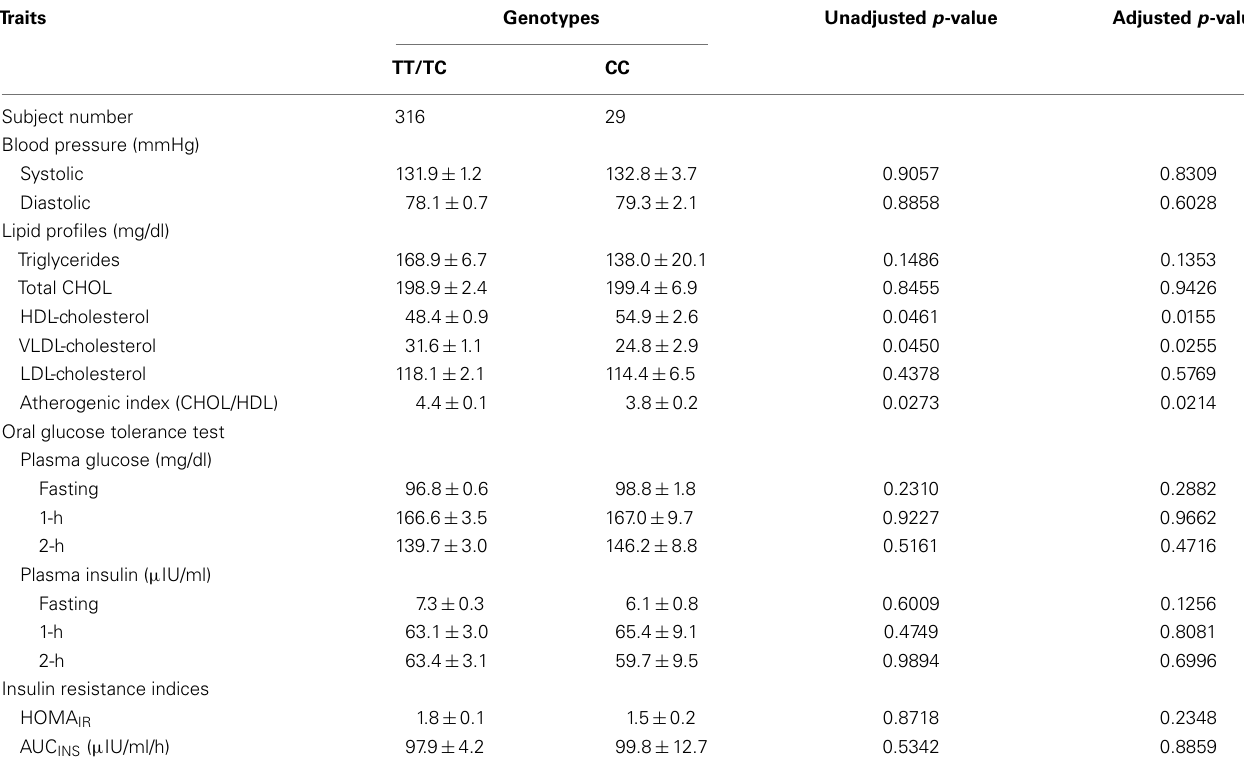
Table 4 | Effect of the ET A receptor genotypes on clinical characteristics of Japanese discordant siblings before and after adjustment for age, gender, and BMI (Mean ± SD)